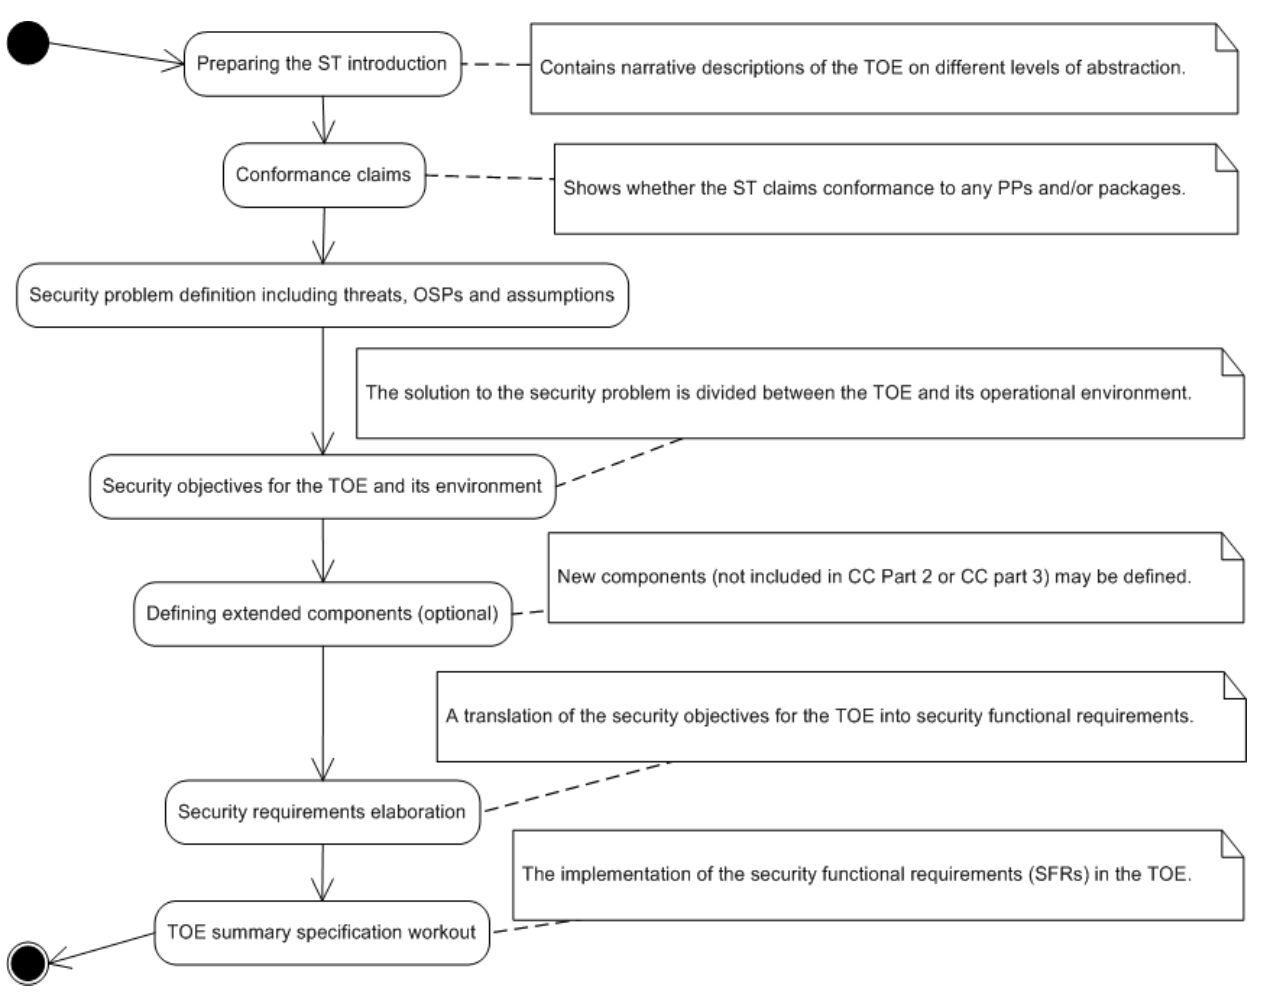
Figure 1. The CC-compliant IT security development process as a UML activity